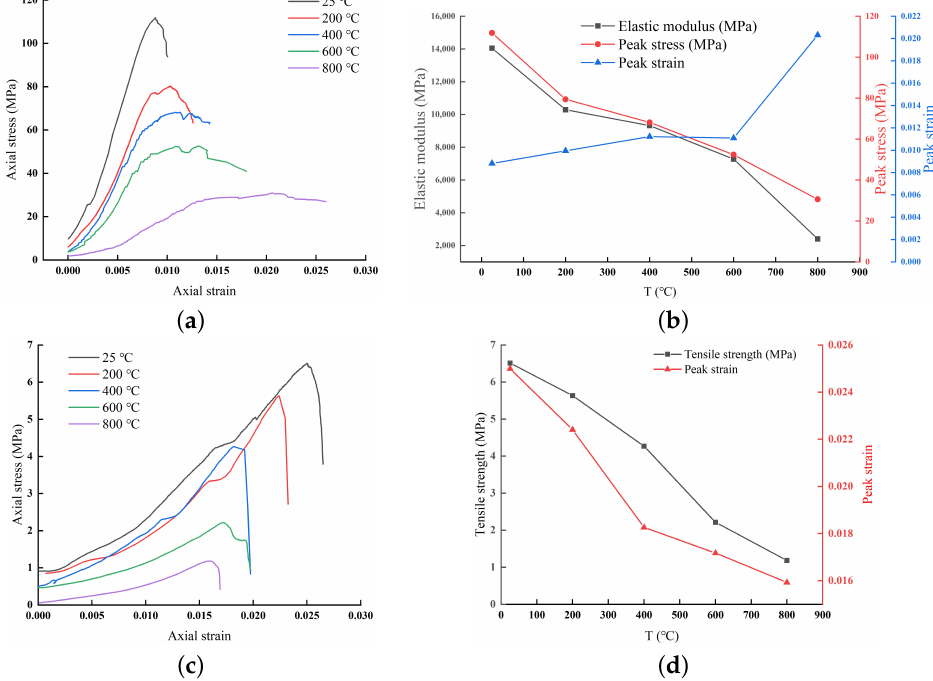
Figure 8. Effect of temperature on the mechanical properties of Beishan granite. ( a ) Uniaxial com- pression test: stress–strain curve; ( b ) Uniaxial compression test: mechanical properties; ( c ) Brazilian splitting test: stress–strain curve; ( d ) Brazilian splitting test: mechanical